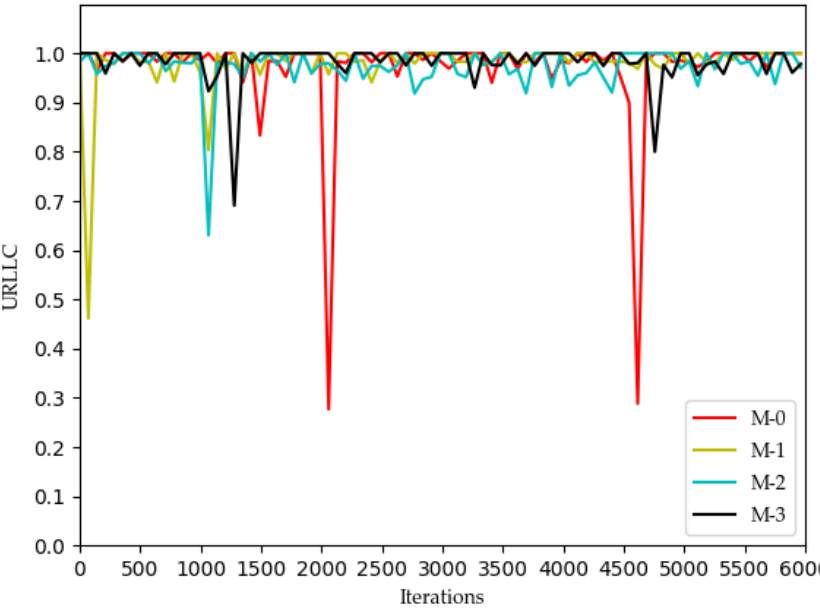
Figure 3. Optimization curve of QoE of URLLC for each MVNO in the lower model based on DQN.